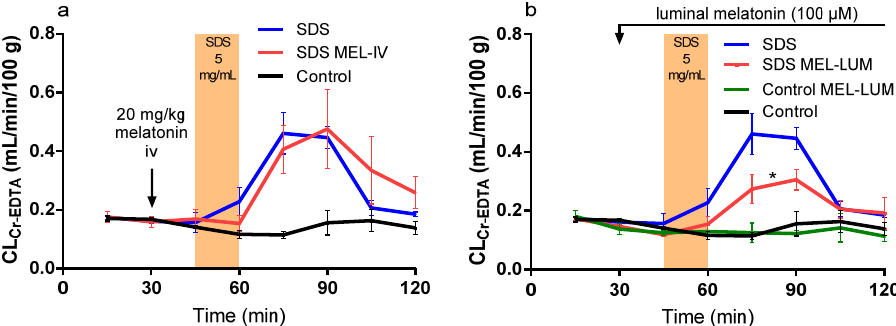
Figure 2. The blood-to-lumen CL Cr-EDTA between 0 and 120 min for the control buffer solution with or without SDS at 5 mg/mL added to the luminal perfusate between 45 and 60 min. ( a ) The effect of intravenously treating rats with a 20 mg/kg melatonin bolus 30 min before the start of SDS exposure. ( b ) The effect of luminally treating rats with melatonin (100 μ M) between 30 and 120 min in the control and SDS experiments. The * represents a significant decrease in CL Cr-EDTA exposure of the luminal melatonin compared to SDS alone.